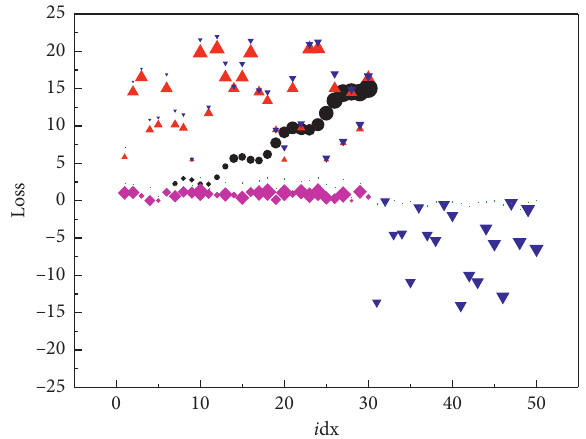
Figure 12: Training balance performance graph.